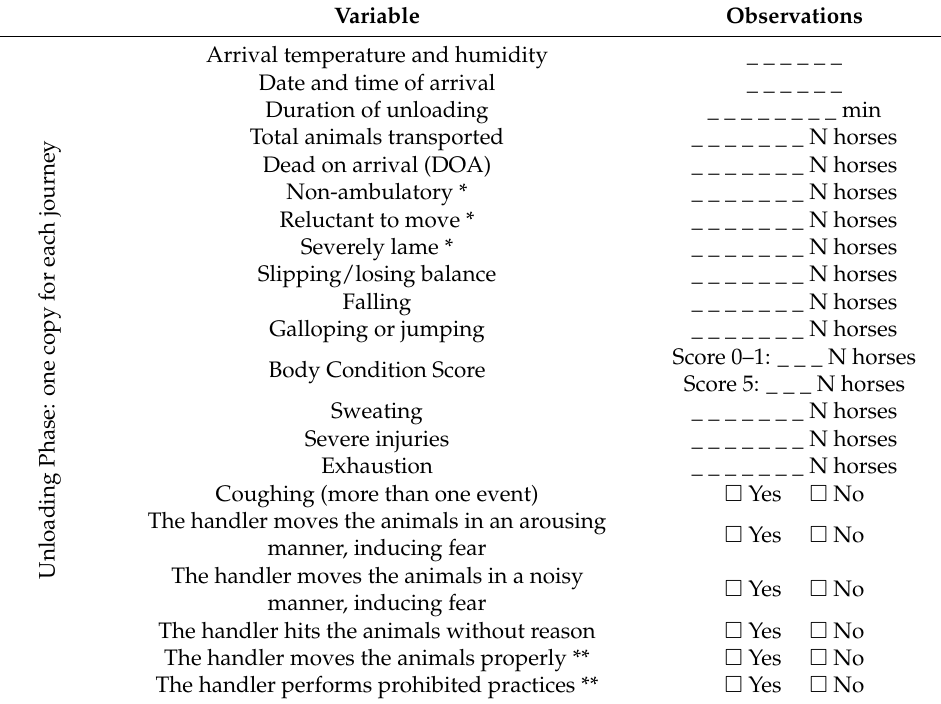
Table 1. Checklist used during unloading to evaluate the welfare status of horses at arrival in a Southern Italy slaughterhouse (modified from Messori et al. [9]).